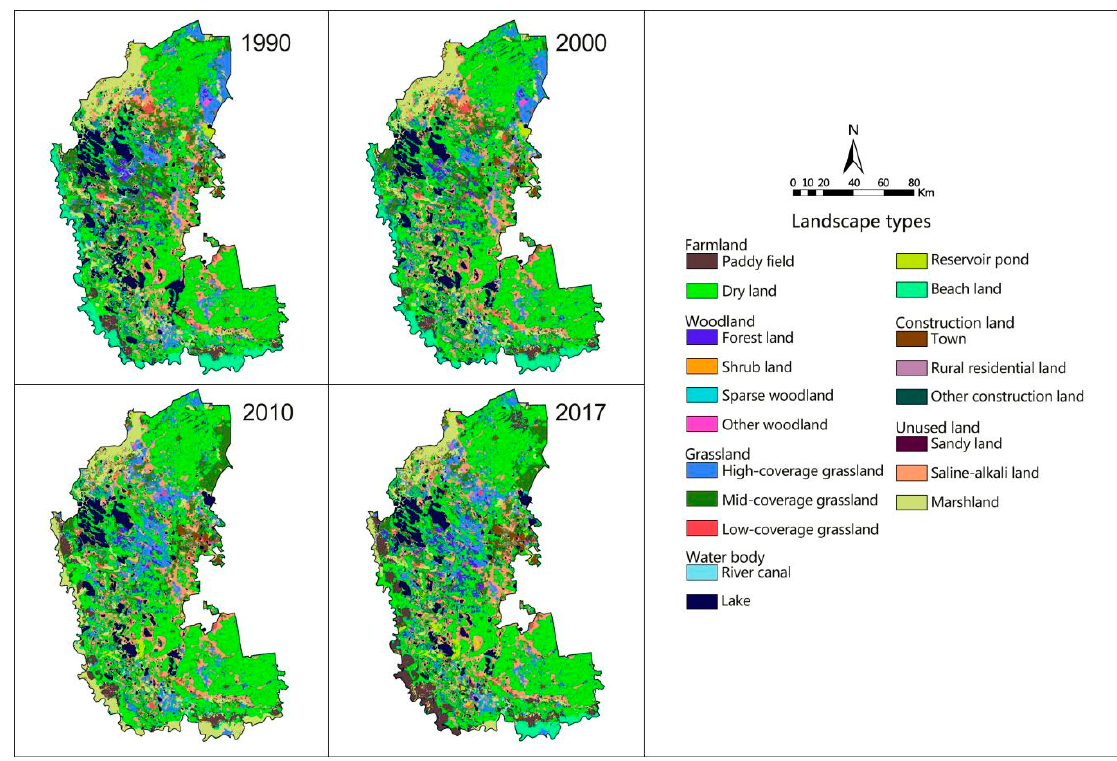
Figure 2. Landscape type maps of the study area in 1990, 2000, 2010 and 2017.